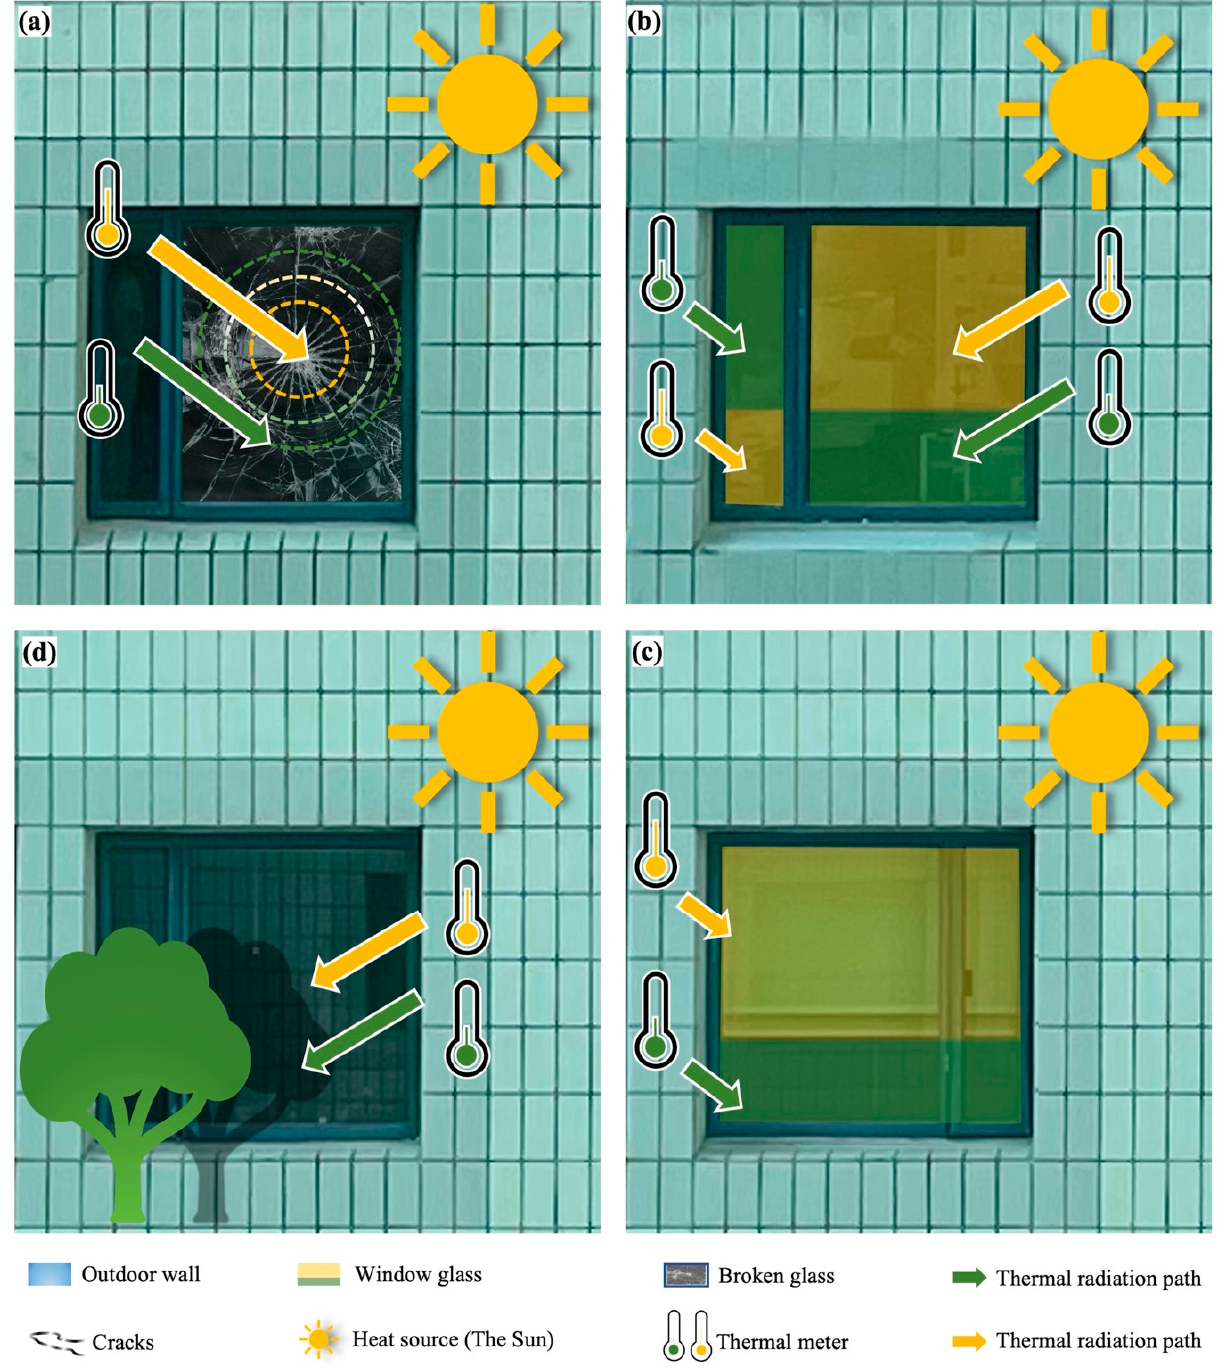
Figure 2. The effect of temperature on window glass. ( a ) Thermal gradient leading to crack initiation and growth of window glass. ( b – d ) The common causes of glass crack initiation and growth are glass color, indoor shading devices, and outdoor shading